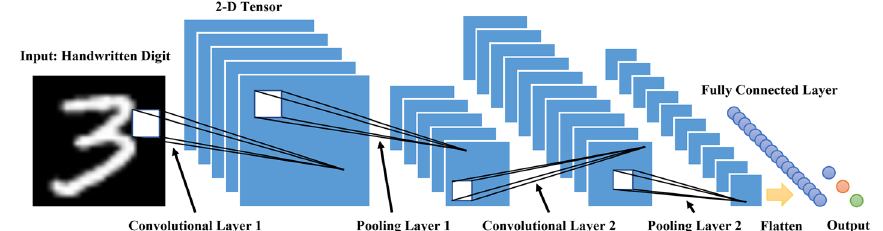
Fig. 2 Conventional CNN architecture applied to a handwritten digit recognition